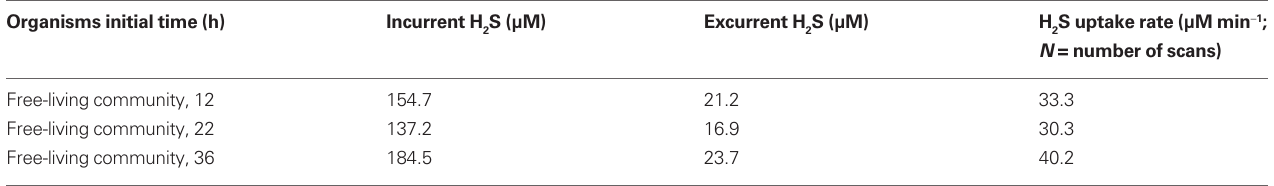
Table 2 | Data for the chemolithotrophic oxidation of H (40 ml volume) recovered from hydrothermal diffuse